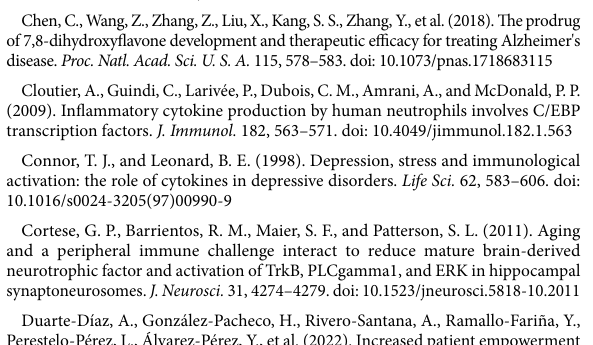
SUPPLEMENTARY FIGURE S3 Experimental procedures in the social interaction test and the classification. (A) Picture of the experiment used in the social interaction test. (B) Schematic of the experimental classification process based on the social interaction score. SI, social interaction; SPT, sucrose preference test; w, week. SUPPLEMENTARY FIGURE S4 Genotyping of C/EBP β +/ − and transgenic C/EBP β mice. (A) Genotyping of C/EBP β +/ − and wild-type mice. Wild-type mice only carry the WT band. C/EBP β +/ − mice carry both bands (WT and Tg). (B,C) Schematic representation of the plasmid, revealing the strategy used to develop the mice. The resultant mice were named Thy1-C/EBP β Tg. (D) Genotyping of Thy1-C/EBP β Tg and wild-type mice. SUPPLEMENTARY FIGURE S5 HFD induces diabetes and depression-like behaviors in wild-type and Thy1-C/EBP β Tg mice. (A) Schematic of the HFD and chow diet course and behavioral tests process in wild-type and Thy1-C/EBP β Tg male mice. (B) Growth curves of wild-type and Thy1-C/EBP β Tg male mice fed with HFD or chow diet. Data represent the mean ± SEM ( n = 10 per group; * p < 0.05, ** p < 0.01, # p < 0.05, ## p < 0.01; two-way ANOVA and Bonferroni’s multiple comparison test). (C) Insulin tolerance test results in wild-type and Thy1-C/EBP β Tg male mice fed with HFD or chow diet. Data represent the mean ± SEM ( n = 6–8 per group; ** p < 0.01, ## p < 0.01; two-way ANOVA and Bonferroni’s multiple comparison test). (D) Glucose tolerance test results in wild-type and Thy1-C/EBP β Tg male mice fed with HFD or chow diet. Data represent the mean ± SEM ( n = 6–8 per group; ** p < 0.01, ## p < 0.01; two-way ANOVA and Bonferroni’s multiple comparison test). (E) Tail suspension test, (F) forced swim test, and (G,H) sucrose preference test results for the above mice. Data represent the mean ± SEM ( n = 13 per group; * p < 0.05; NS, not significant; one-way ANOVA and Bonferroni’s multiple comparison